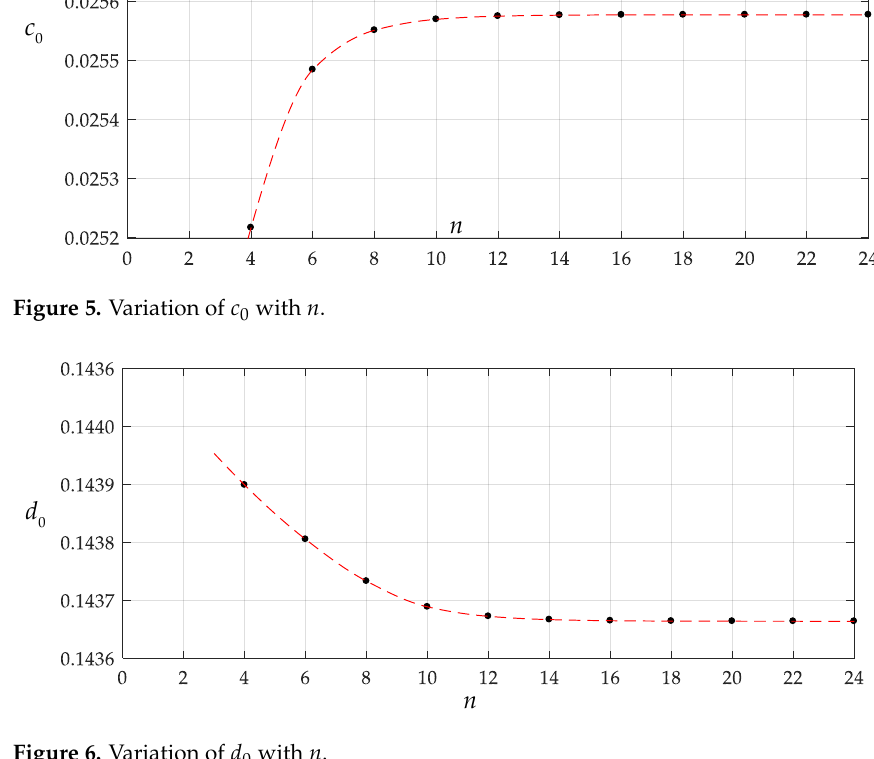
Figure 6. Variation of d 0 with n . Table 2. ( a ) The values of c i at different n ; ( b ) The values of c i at different n ; ( c ) The values of c i at different n ; ( d ) The value of c 24 at n =